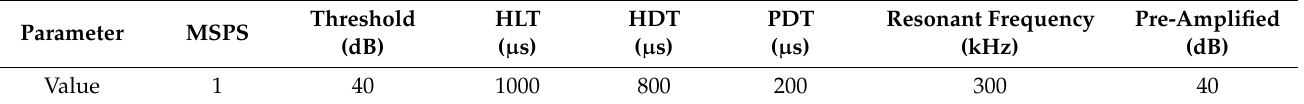
Table 1. Acquisition parameters of the AE system.